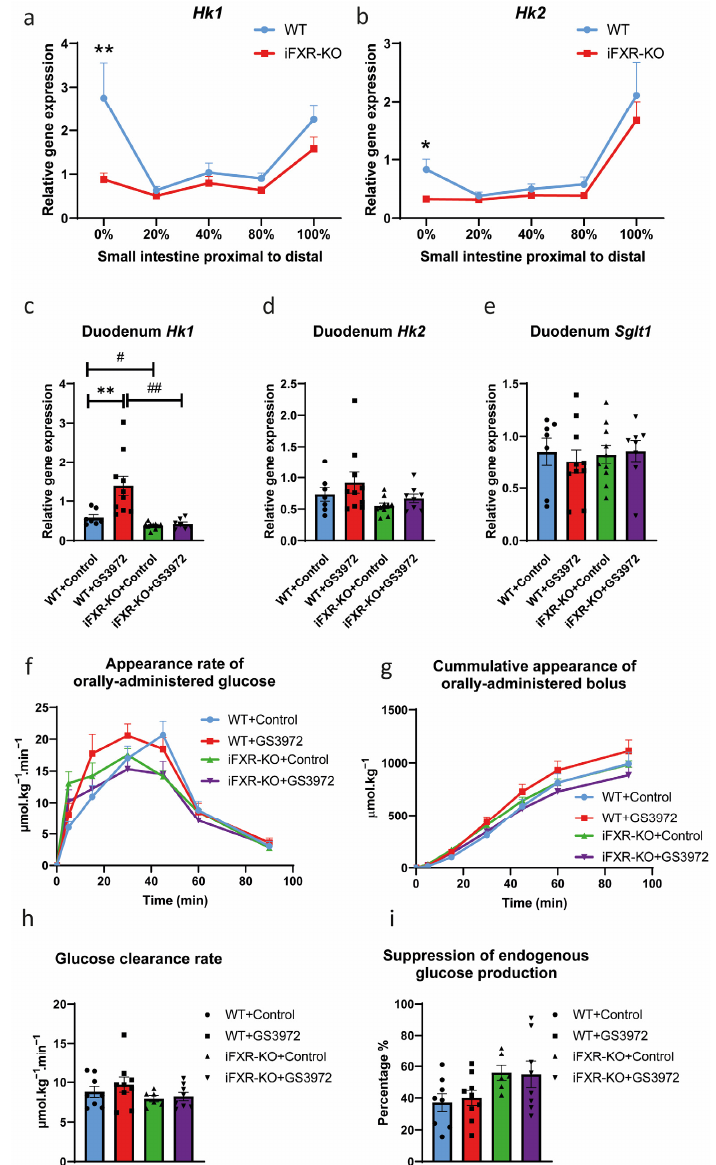
Figure 4. Activation of FXR increased Hk1 expression in duodenum. ( a , b ) Quantitative real-time PCR of glucose absorption gene expression ( Hk1 and Hk2 ) in 5 parts of intestine (0, 20, 40, 80 and 100% of small intestine from proximal to distal) from wild-type (WT) and intestine-specific FXR − / − (iFXR-KO) mice on one-week high-fat-diet (HFD) chow diet; ( c – e ) Quantitative real-time PCR of glucose absorption gene expression ( Hk1 , Hk2 and Sglt1 ) in duodenum from WT and iFXR-KO mice treated with or without GS3972 for one week under HFD condition; ( f ) Orally administrated D-[U- 13 C] glucose appearance rate and ( g ) recovery of orally administrated glucose bolus at 0, 5, 15, 30, 45, 60 and 90 min during glucose absorption test from WT and iFXR-KO mice treated with or without GS3972 for one week under HFD; ( h ) Glucose clearance rate and ( i ) hepatic glucose suppression from WT and iFXR-KO mice treated with or without GS3972 for one week under HFD. Panels ( a , b ): Statistical significance was determined using the Mann–Whitney test in WT and iFXR-KO mice. n = 5/group, data are represented as mean ± SEM, * p < 0.05 and ** p < 0.01. Panels ( c – i ): Statistical significance was determined using Kruskal–Wallis H-test followed by post-hoc Conover pairwise comparisons. n = 7–9/group. Data are represented as mean ± SEM, * p < 0.05 and ** p < 0.01 when mice with GS3972 treatment compared with control, # p < 0.05 and ## p < 0.01 when iFXR-KO mice compared with WT